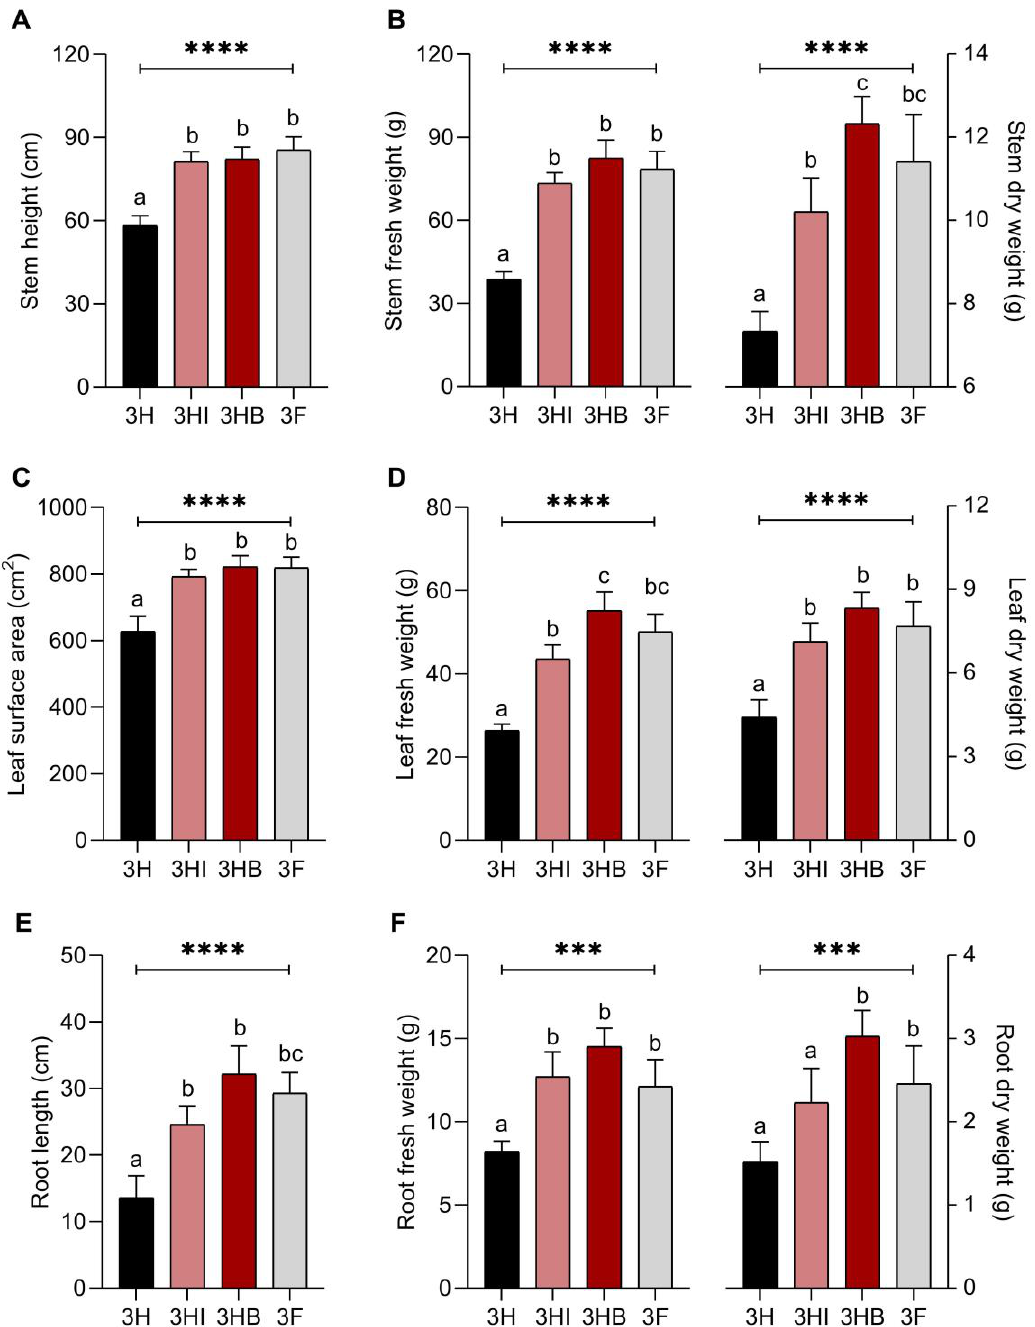
Figure 2. Effect of free-cell and encapsulated E. hormaechei 40a on the physiology of okra after 60 days grown under greenhouse conditions. ( A ), stem height; ( B ), stem fresh and dry weight; ( C ), leaf area; ( D ), leaf fresh and dry weight; ( E ), root length; ( F ), root fresh and dry weight. Data (mean ± standard deviation, n = 4) followed by different letters between treatments indicate significant differences (one-way ANOVA + Tukey multiple comparisons test at p ≤ 0.05). p -value summary: ns, >0.05; *, <0.05; **, <0.01; ***, <0.001; ****, <0.0001. Half-dose PK-fertilizer, 3H; half-dose PK-fertilizer and free-cell strain 40a, 3HI; half-dose PK-fertilizer and encapsulated strain 40a, 3HB; full-dose PK- fertilizer, 3F.